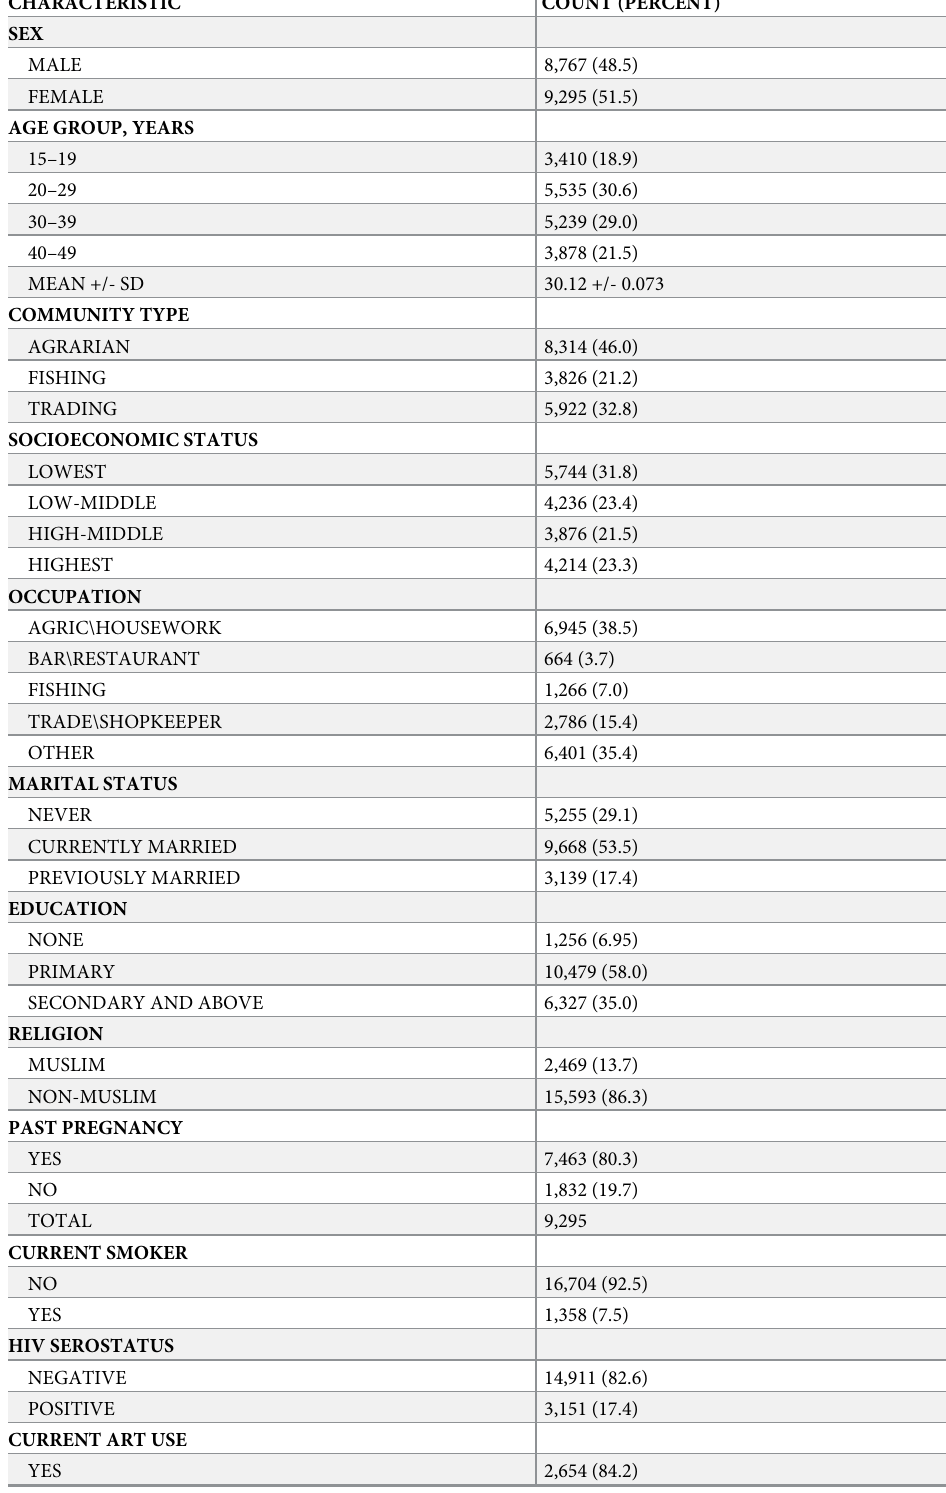
Table 1. Participants’ demographics and